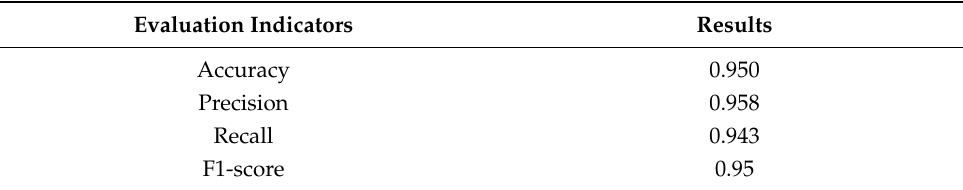
Table 3. Evaluation indicator results for traffic accident classification.